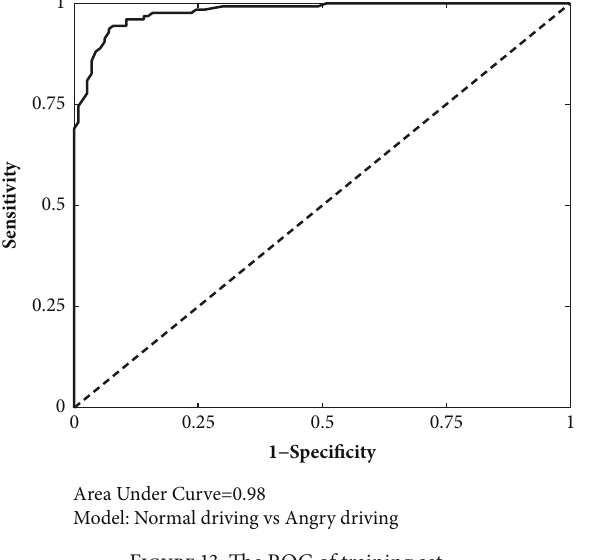
Figure 15: The prediction result of test sample.